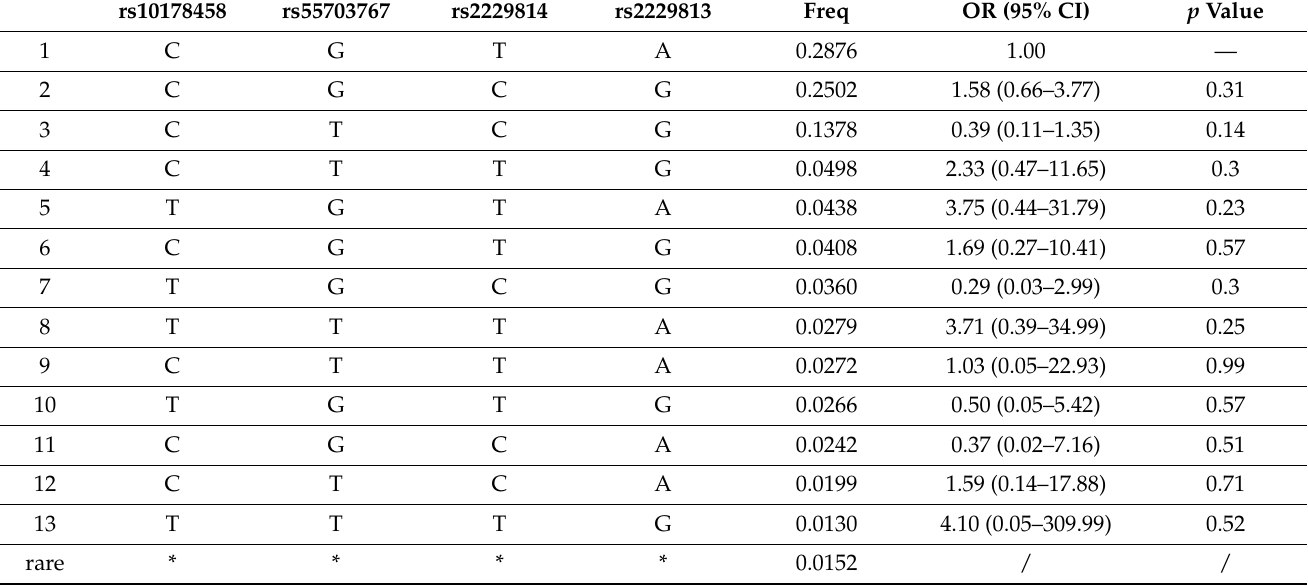
Table 5. Odds ratio (OR) calculations of the collagen genes single-nucleotide polymorphisms